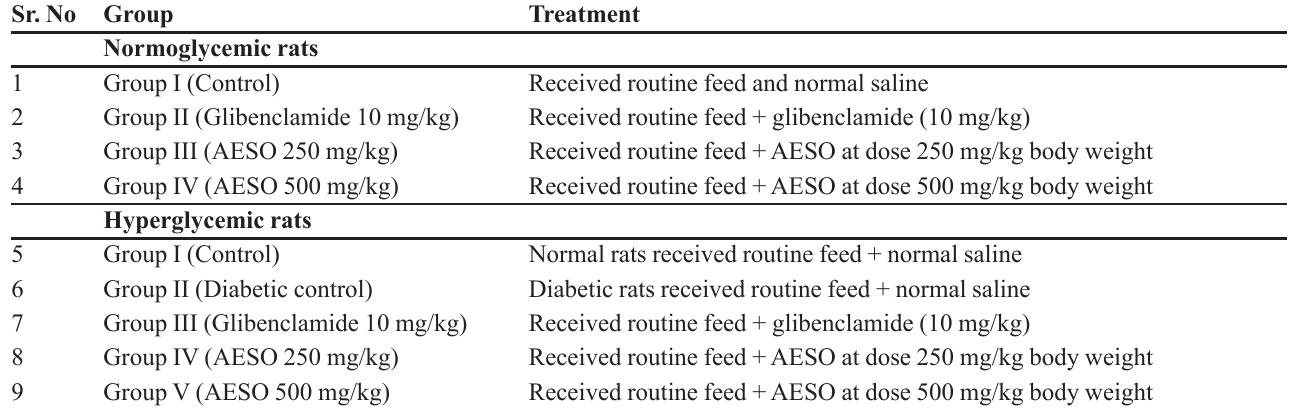
TABLE I -OGTT treatment groups Sr.